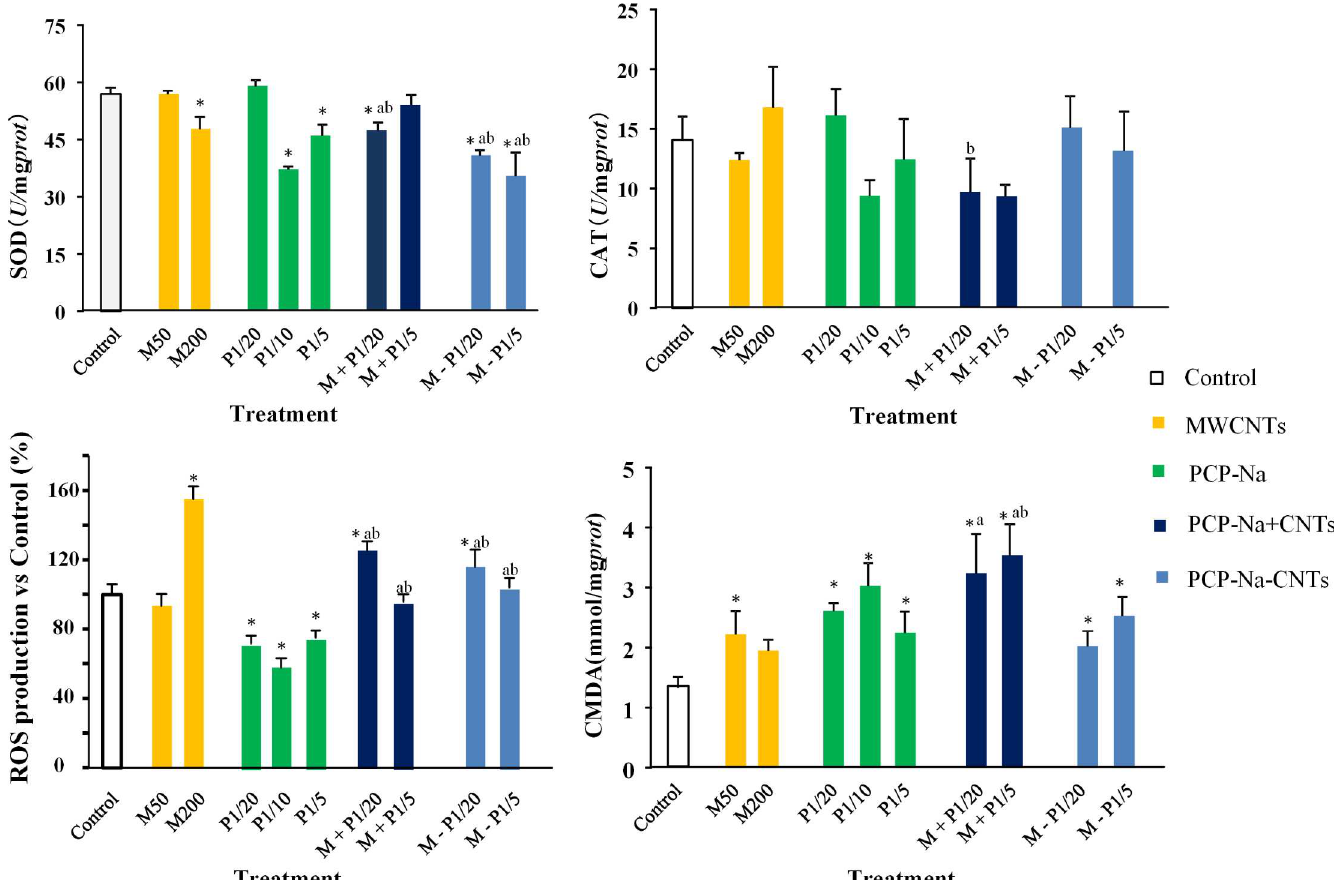
Fig 2. Activities of antioxidant enzymes of the earthworm coelomocytes after exposureto different treatments of MWCNTs (M), PCP-Na (P), and their complex (A) SOD, (B) CAT, (C) ROS, and (D) MDA. Data are expressed as the mean ± standarddeviation(SD) of quadruplicateanalyses. * means which has a significantdifference from the control (CK), a means the complex group which had significantdifference from M50, b means the complex group which had significantdifference from corresponding P1/20 or P1/5 ( p <